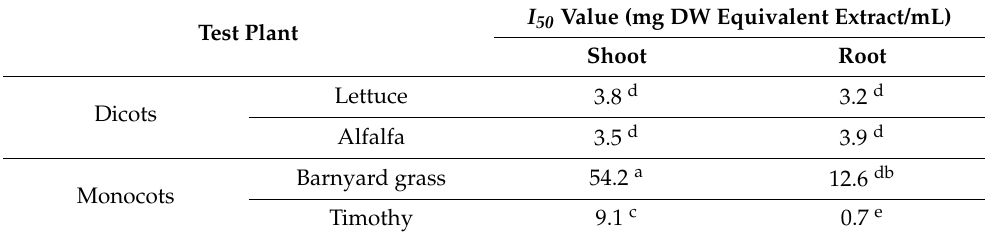
Table 1. I 50 values (mg DW equivalent extract/mL) of the shoot and root growth of lettuce, alfalfa,